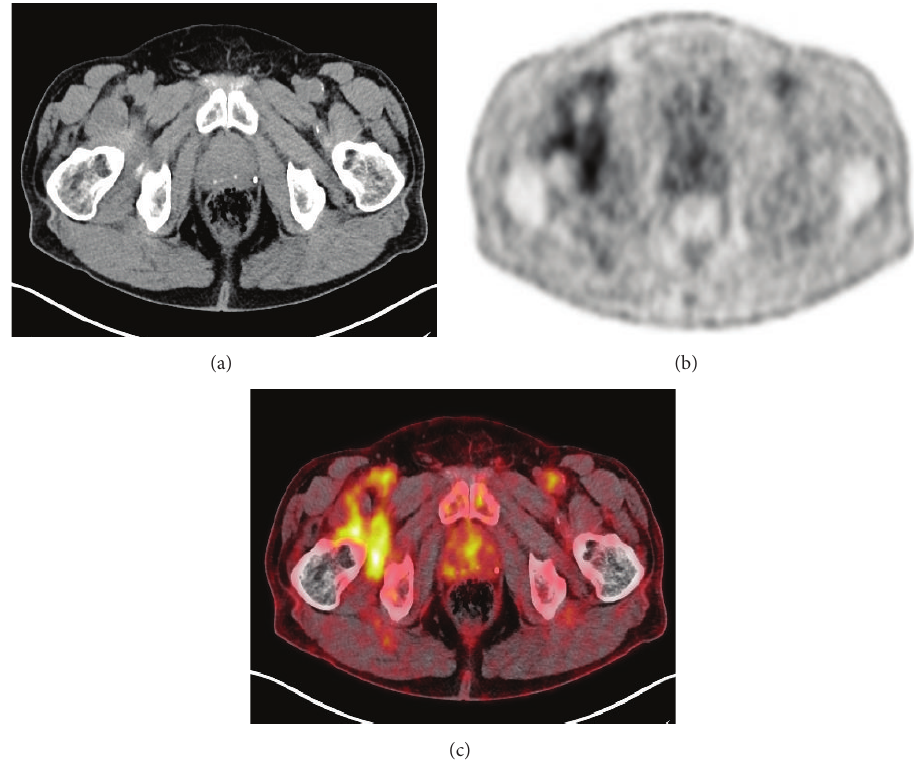
Figure 4: (a) Computerized tomography (CT) axial scan. (b) Fluorine-18-fluorodeoxyglucose positron emission tomography ( 18 F-FDG PET) axial scan. (c) 18 F-FDG-PET/CT fusion image. A moderate uptake in the anterior-lower aspect of the right hip joint is appreciable, more evident in the peripheral portion of the neoformation. A remarkable uptake is present in right hip joint.